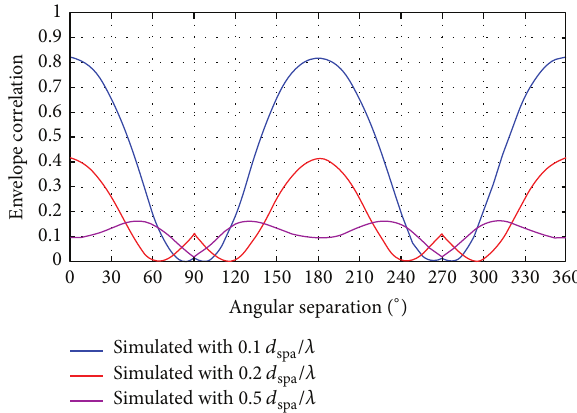
Figure 4: Combined correlation function versus angular difference with spatial distance as parameter.